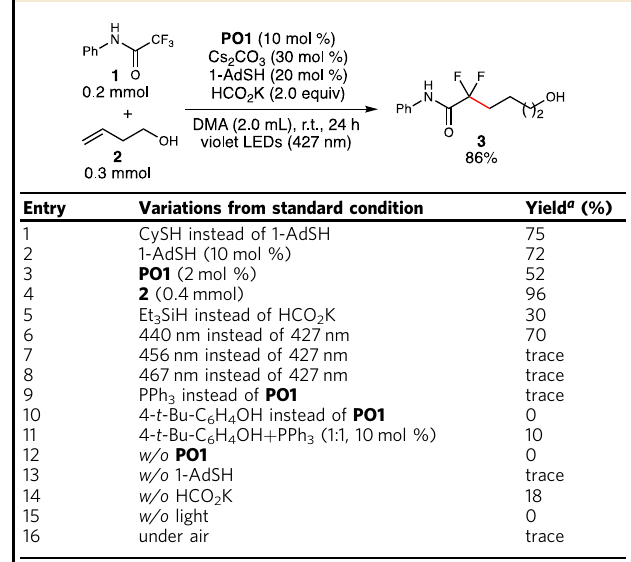
Table 1 summaries key reaction parameters. Using cyclohex- anethiol as the HAT catalyst reduced the yield (entry 1, Table 1).